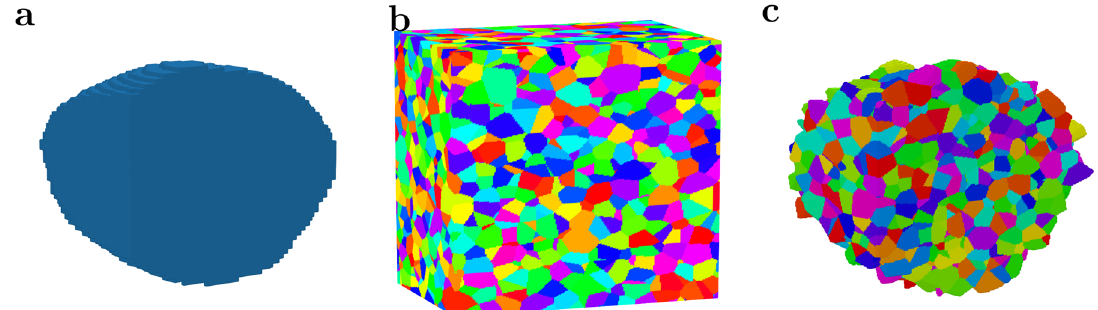
Fig. 5 3D rendering of model realizations. Volumetric cutouts of (discretized) samples drawn from the outer shell model ( a ) and the grain architecture model ( b ), and the corresponding realization of the multi-scale model ( c